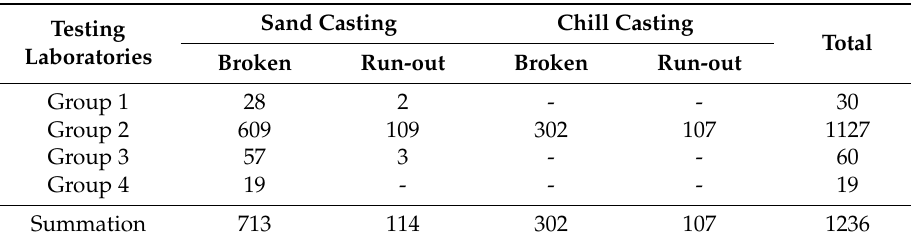
Table 5. Number of test results by test laboratories.